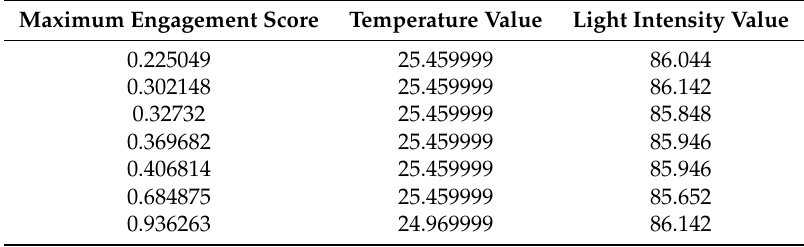
Table 2. Calculating the maximum engagement results for one session.